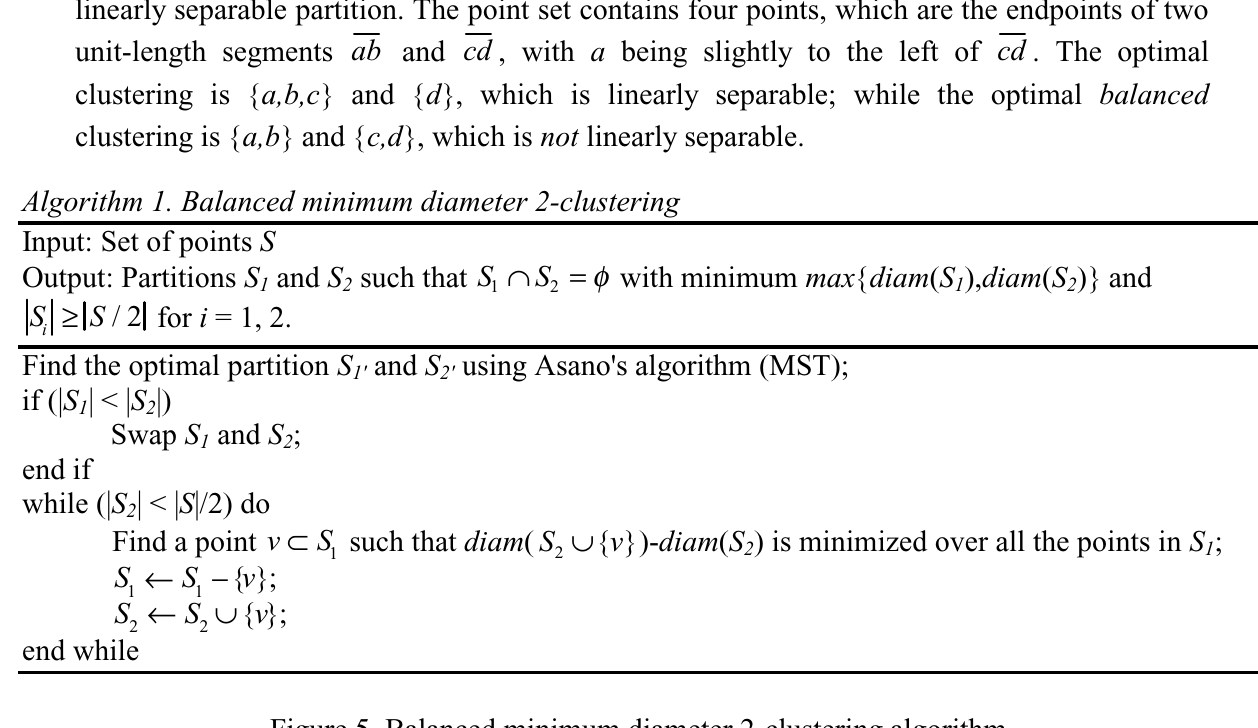
Figure 5. Balanced minimum diameter 2-clustering